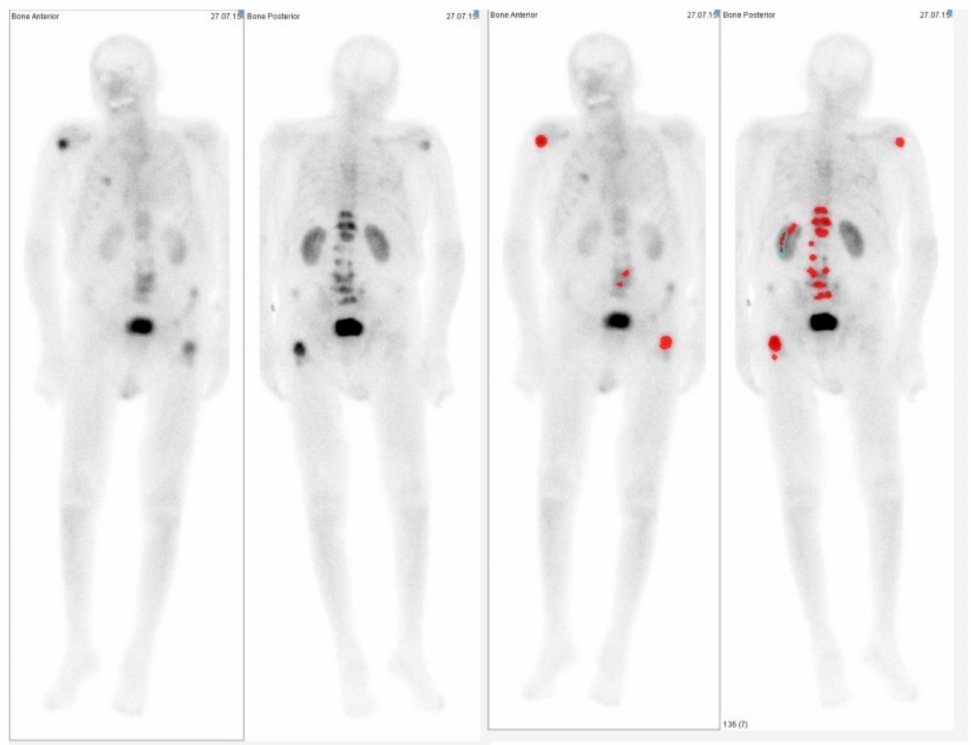
Figure 3. Example of a case in which the semiautomatic tool uptake in the renal system was classified as metastasis (red marked areas).